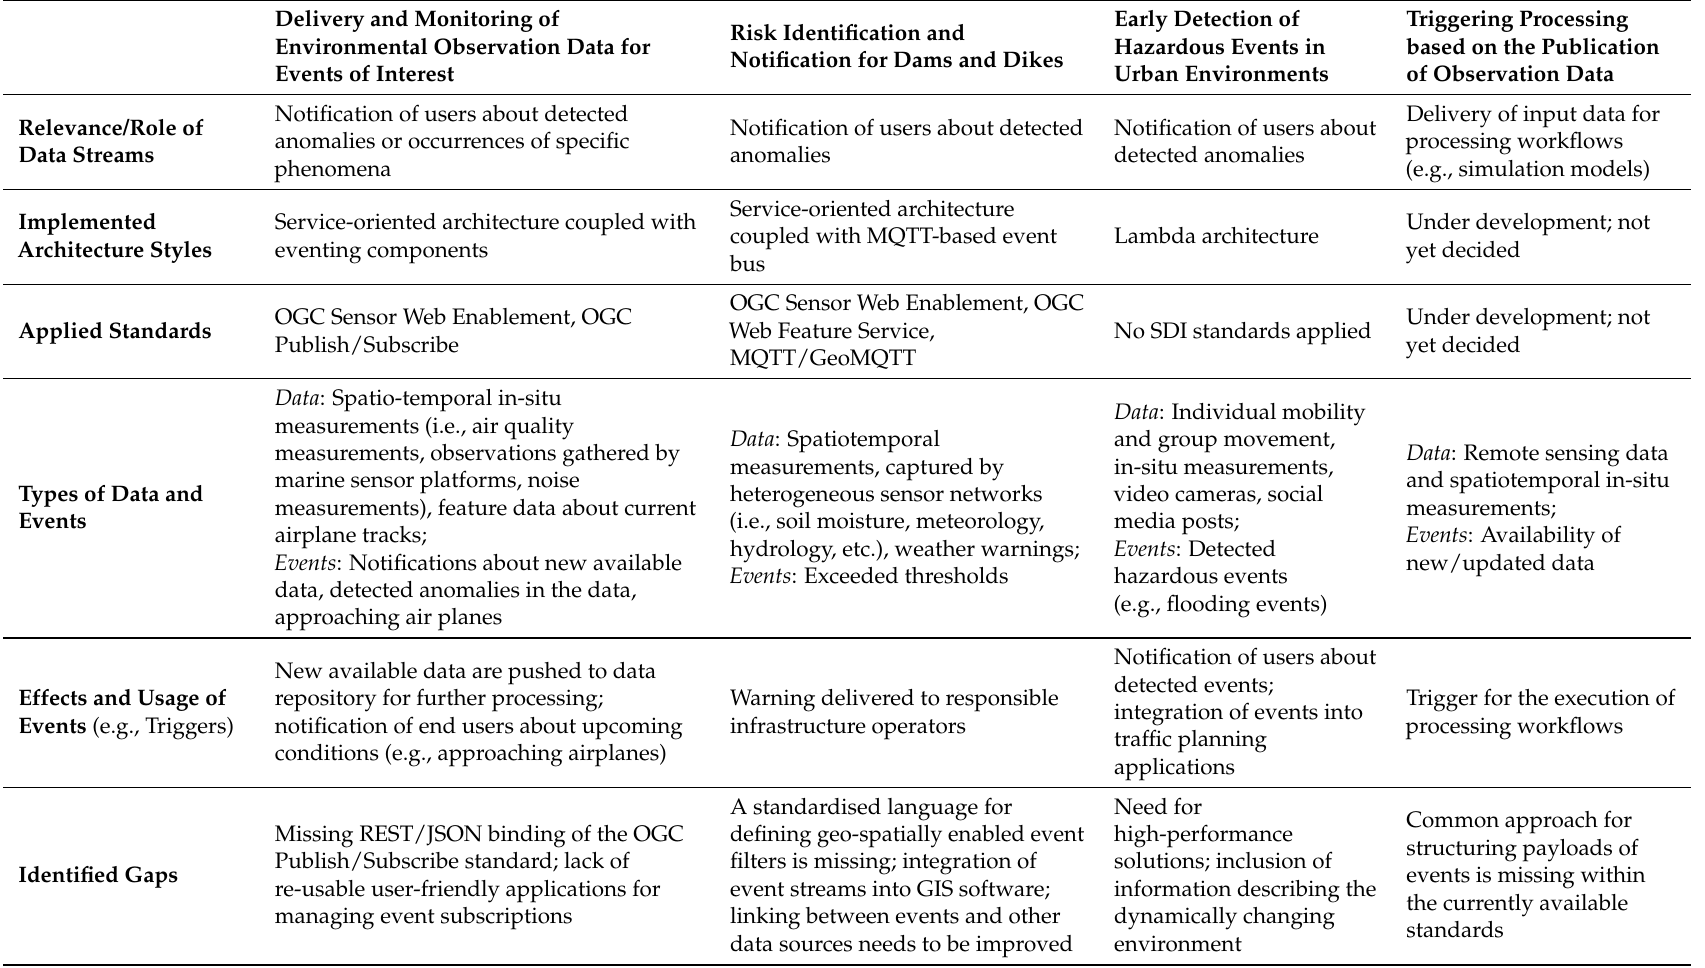
Table 1. Overview of Application Scenarios and Relevant